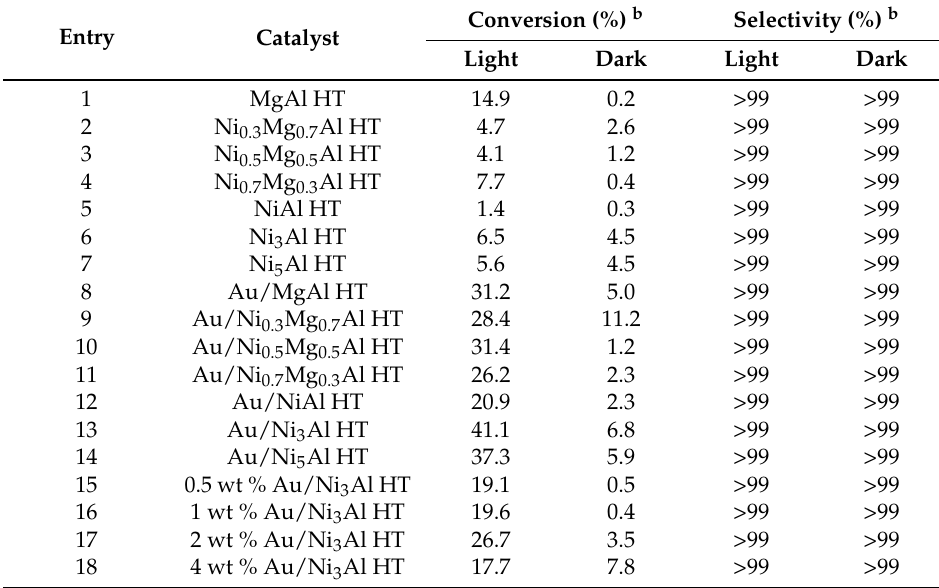
Table 2. Oxidation of benzyl alcohol over the supported gold catalysts a .